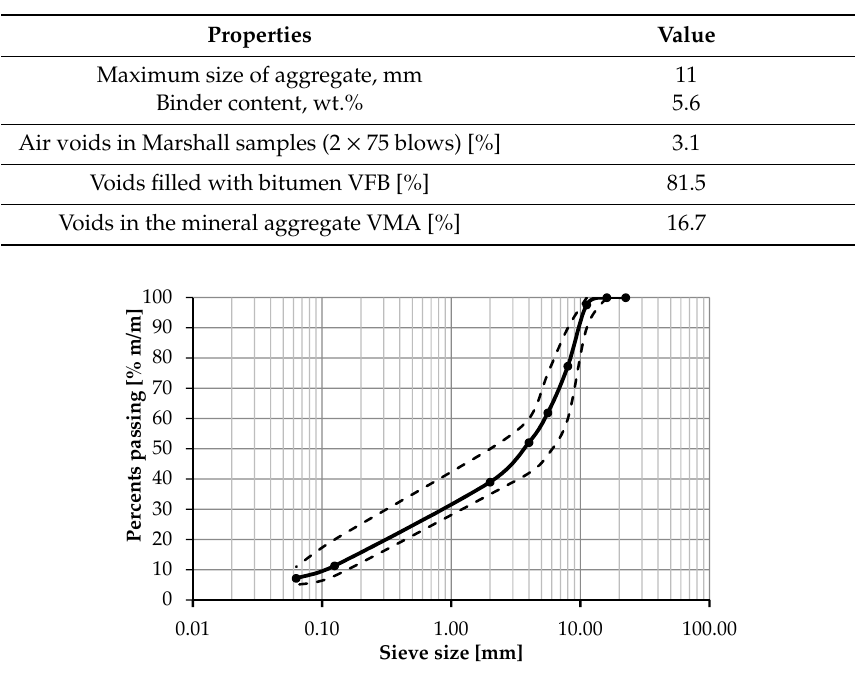
Figure 3. Grading curve of the used asphalt concrete mix and grading envelope according to the technical guidelines WT-2:2014 [38].